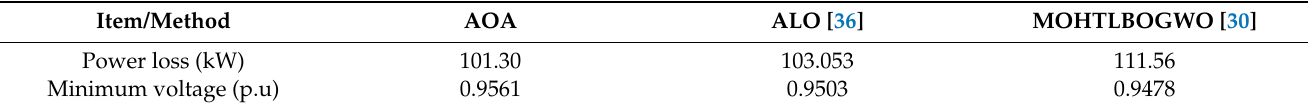
Table 8. Comparison of the results with previous